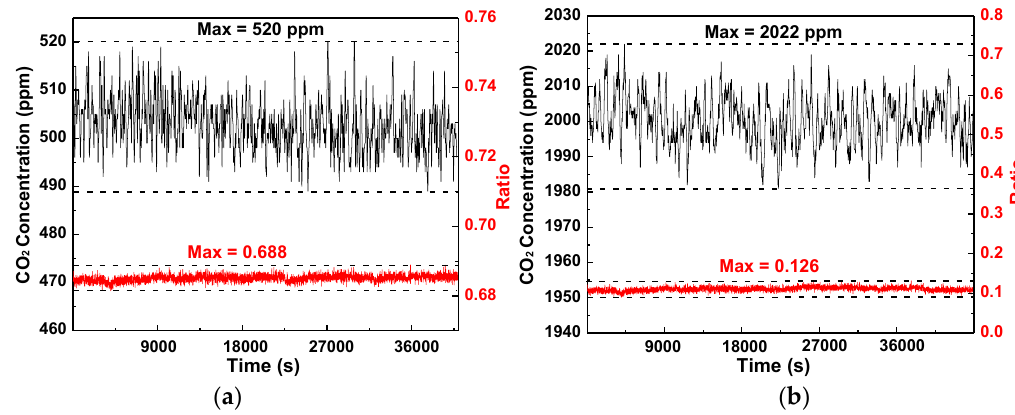
Figure 7. ( a ) Long-term measurement results on a CO 2 standard sample with a concentration level of 500 ppm; ( b ) Long-term measurement results on a CO 2 standard sample with a concentration level of 2000 ppm.